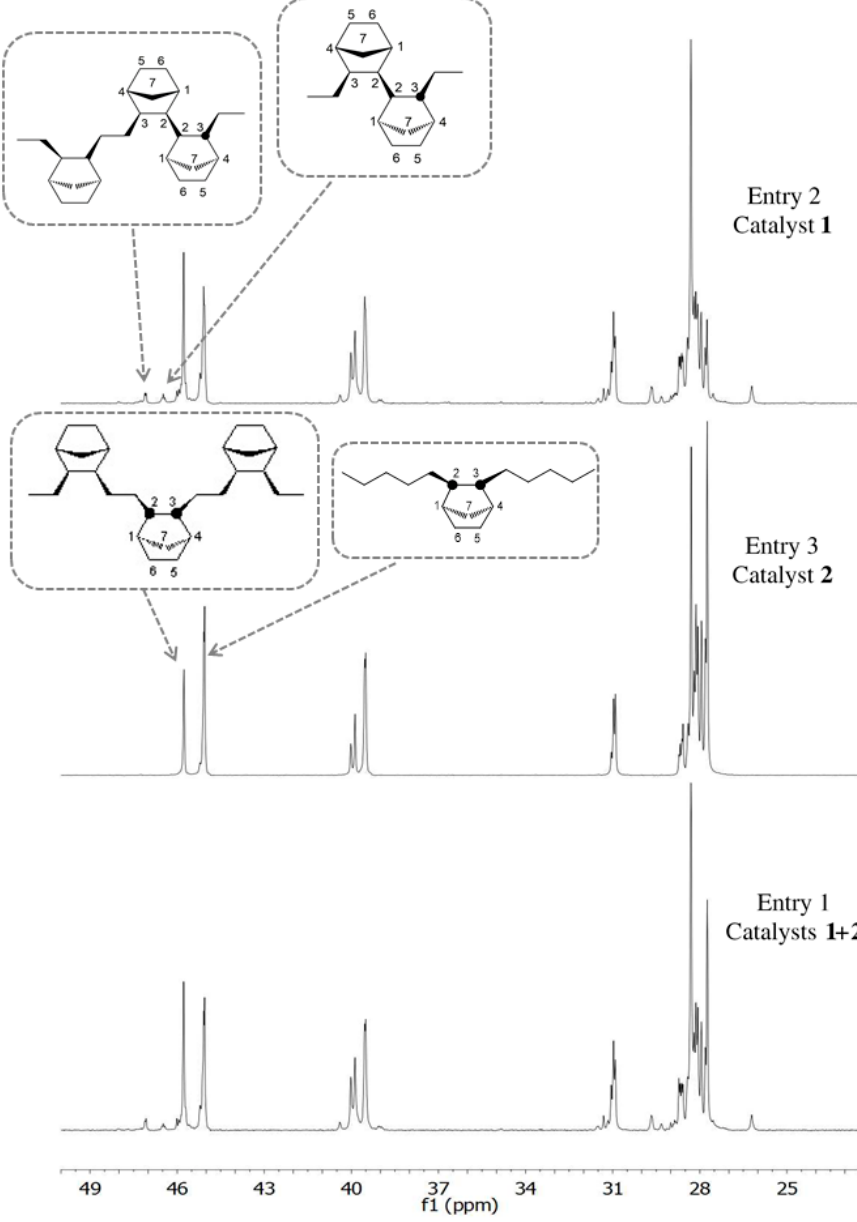
Figure 2. Comparison of 13 C-NMR spectra of poly(ethylene– co –norbornene) samples entry 1 (prepared with catalysts 1 + 2 ), entry 2 (prepared with catalyst 1 ) and entry 3 (prepared with catalyst 2 ) synthesized using the feed ratio [N]/[E] = 1.3.